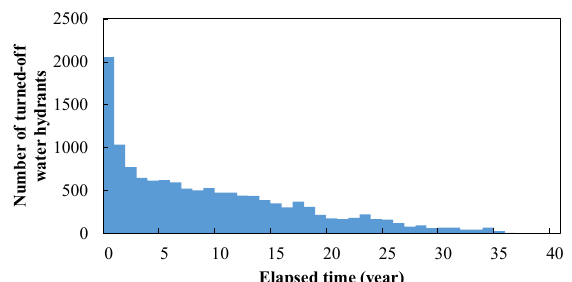
Figure 1. Histogram of the turned-off water hydrants in each elapsed time (year) when they are off.